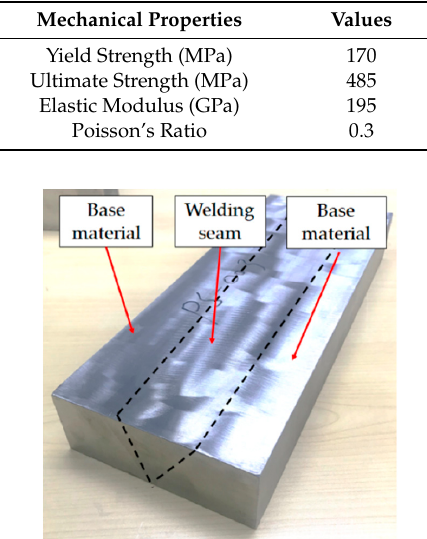
Table 2. Mechanical properties of the base material.